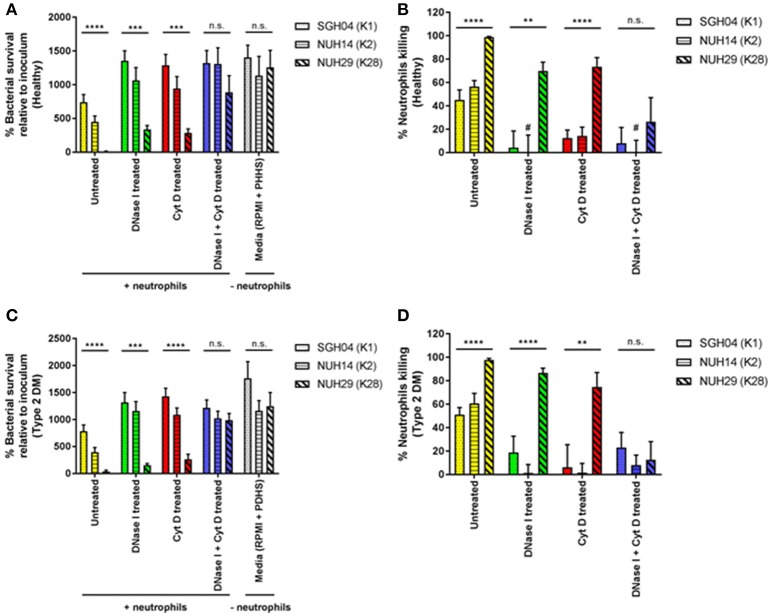
Ex vivo interactions between healthy as well as poorly controlled type 2 DM neutrophils and different hvKP capsule types. Neutrophils isolated from healthy donors (n = 8; mean age = 40.0 ± 11.7 years; normal fasting blood glucose and HbA1c levels) or type 2 DM donors with poor glycemic control (n = 8; mean age = 48.5 ± 13.9 years; mean HbA1c = 10.6 ± 1.7%) were pretreated with DNase I, cytochalasin D, DNase I + cytochalasin D, or left untreated. This was followed by infection with the K1 strain SGH04, K2 strain NUH14 and K28 strain NUH29. As a control, strains were also inoculated into infection media (RPMI + 10% pooled healthy human serum or RPMI + 10% pooled diabetic human serum) without neutrophils. (A,C) Bacterial survival was expressed as percentage change from inoculum, calculated with the equation: (CFU+neutrophils at 2-h/CFU−neutrophils at 0-h) × 100. (B,D) Percentage neutrophil killing was calculated with the equation: 100—[(CFU+neutrophils at 2-h/CFU−neutrophils at 2-h) × 100]. *Statistical analyses in the graphs were by ANOVA. #Denotes bars with negative values that were not visually represented in the graph. Error bars represent SEM. **p < 0.01, ***p < 0.001, ****p < 0.0001.